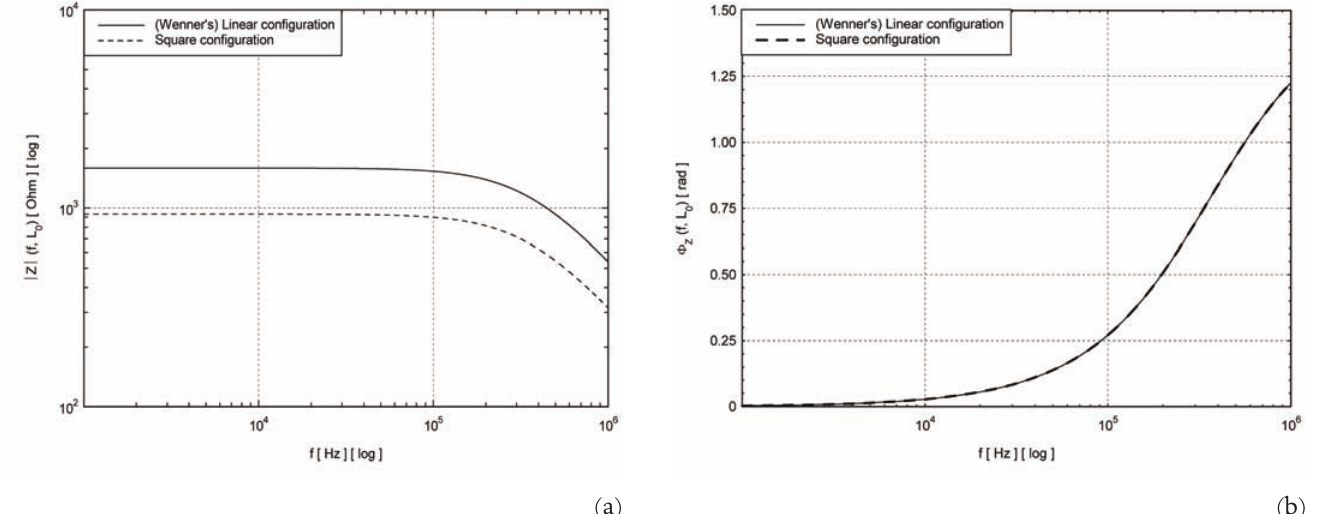
= 1 m and in galvanic contact on a concrete of 0